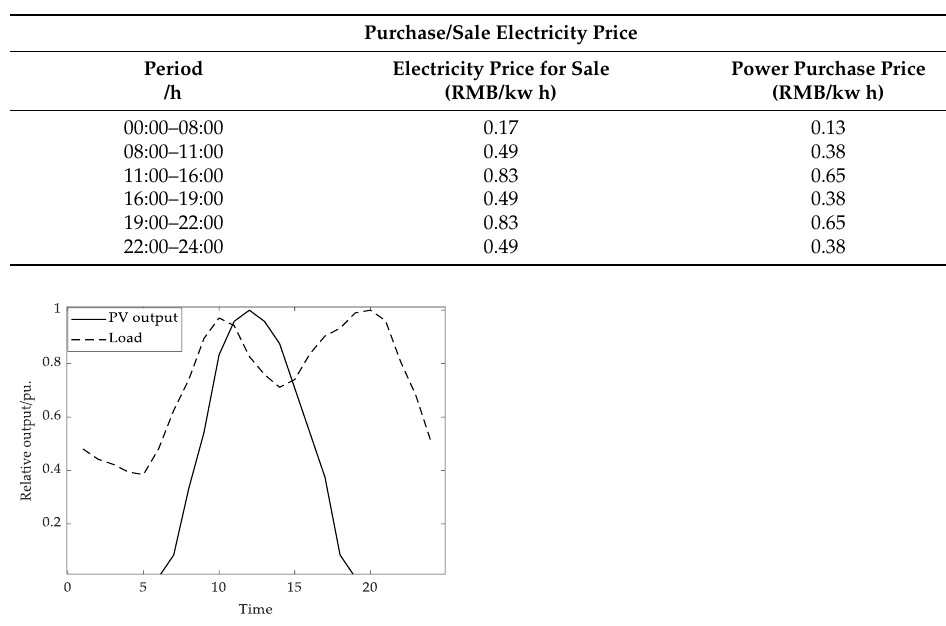
Figure 5. IEEE 33-bus distribution network. Table 1. Time of use power price.